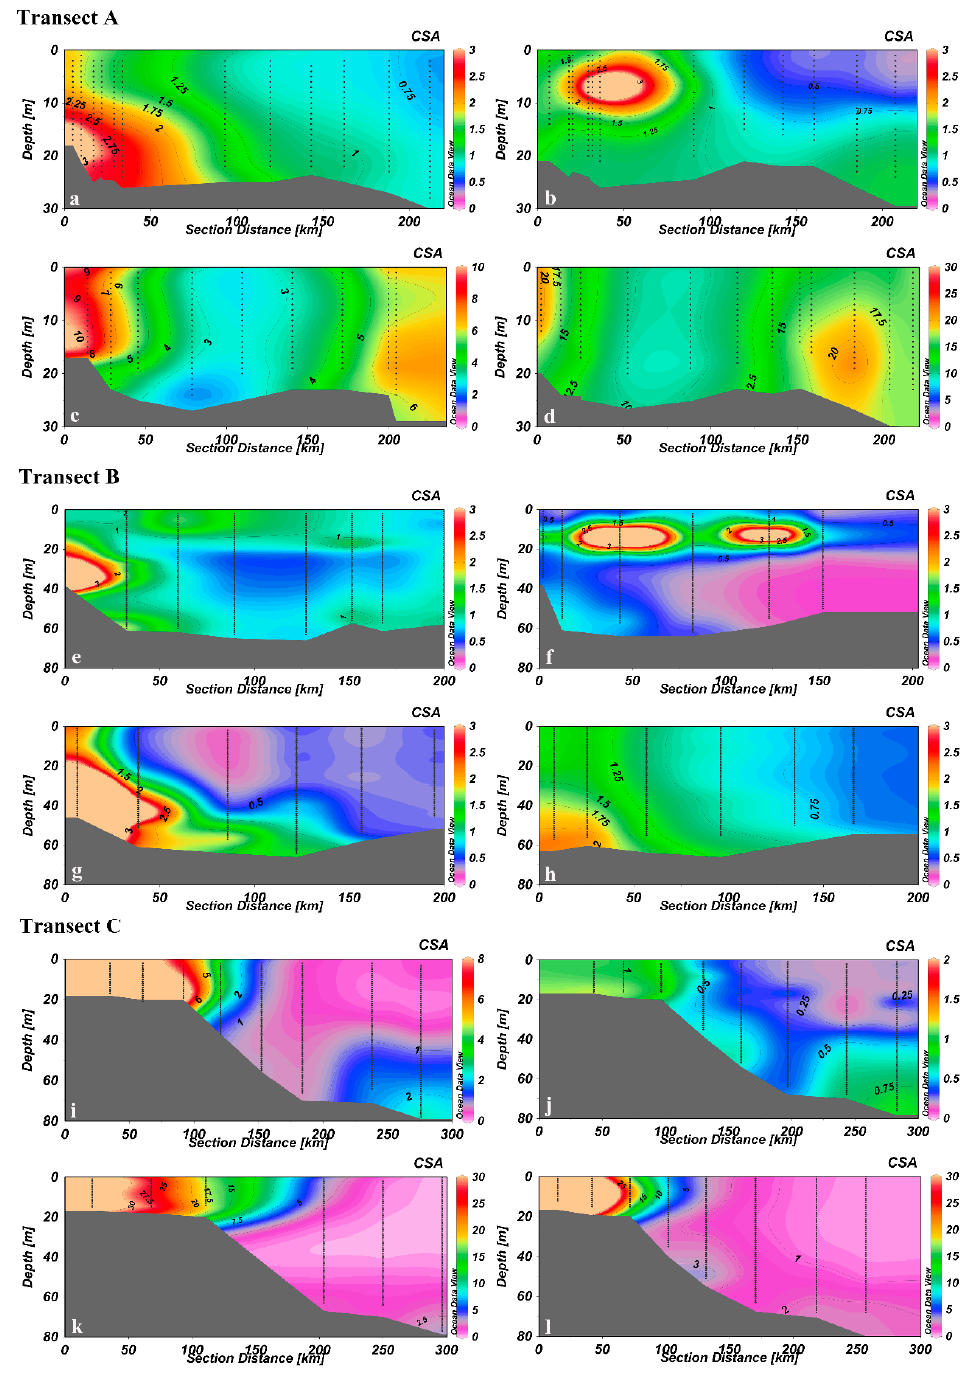
Figure 7. The CSA vertical profiles (unit: m − 1 ) at each cruise: ( a – d ) are transect A, ( a – d ) are spring, summer, autumn, winter, respectively; ( e – h ) are transect B, the sequence is the same as that on transect A; ( i – l ) are transect C, the sequence is the same as that on transect A. The interpolation method is the same as Figure 3.